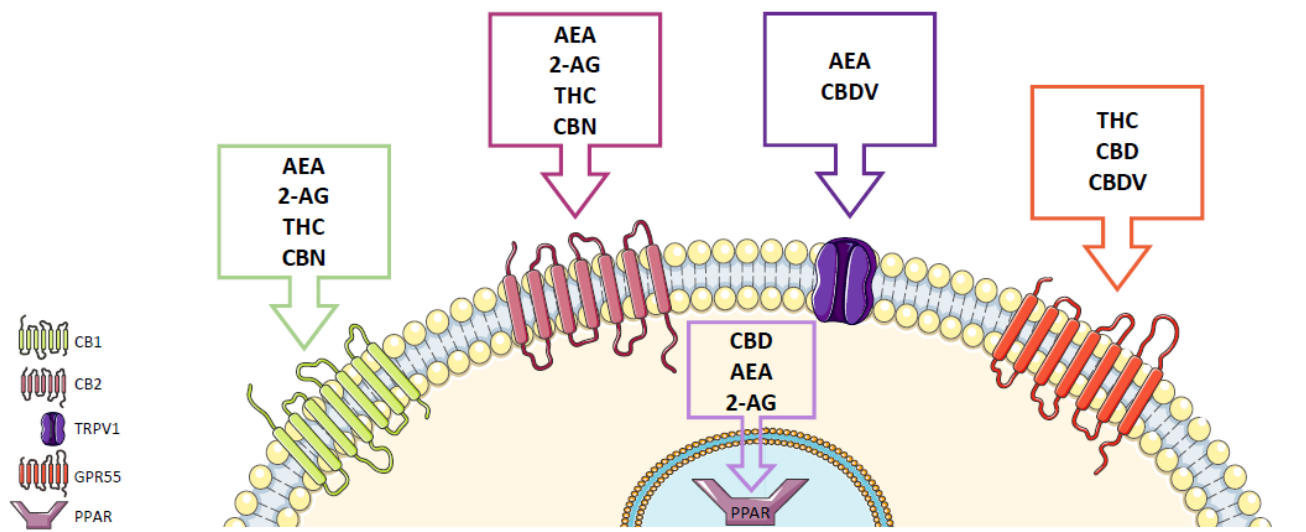
Figure 2. Cannabinoids and their receptors. The cannabinoid receptors CB1 and CB2, GPR55, as well as the cation channel TRPV1 and the nuclear receptor PPAR, are presented. AEA—anandamide;